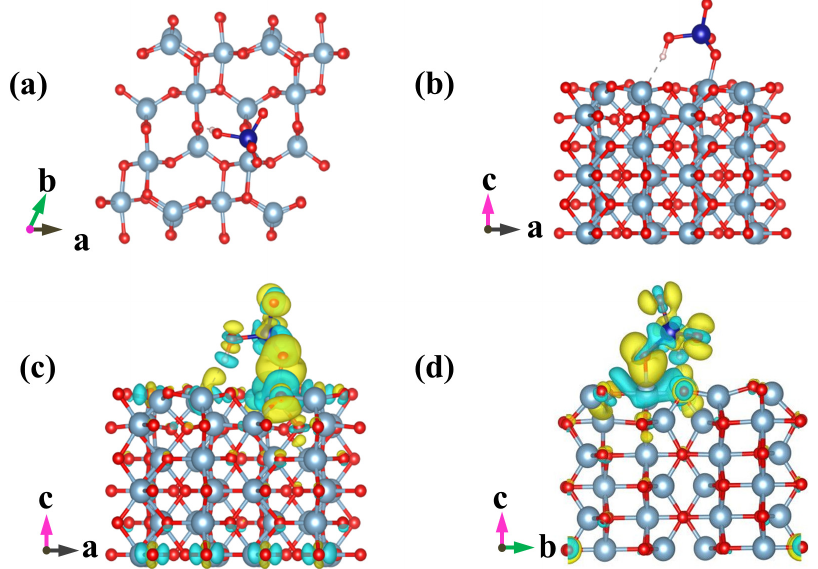
Figure 7. Optimized geometric configurations for HCrO 4 − adsorbed on Al 2 O 3 (010) ( a , b ), and isosurface representations of charge difference ( c , d ). The accumulation and depletion of electrons are represented by the yellow and cyan regions, respectively. Isosurface value = 0.002 e/bohr 3 . Aluminum atoms are gray, oxygen atoms are red, chromium atoms are blue, and hydrogen atoms are white.